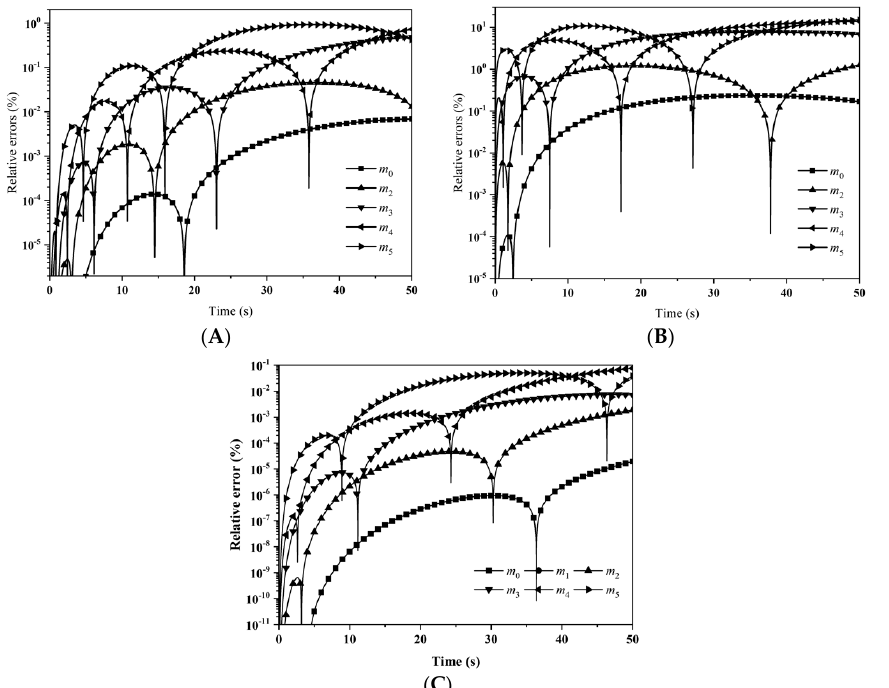
Figure 17. Evolution of the relative errors for the first six moments for the pure breakage process with square kernel, exponential initial PSD, and uniform daughter distribution: ( A ) LFPQMOM; ( B ) QMOM; and ( C ) FPQMOM (square: m 0 ; up triangle: m 2 ; down triangle: m 3 ; left triangle: m 4 ; right triangle: m 5 ).